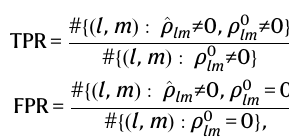
Fig. 2 | Comparisons of estimation accuracy and false/true positive rate (FPR/ TPR) for identifying linear relationships within an ecosystem. The average relative norm loss (Frobenius/Spectral) and FPR/TPR of various correlation meth- ods are shown in a , b , respectively. Synthetic data were generated from negative- binomial(NB)distributions.TheX-axisdenotesthesimulationsettings,whicharea combination of sample size n , number of taxa d , and the dispersion parameter α . Resultsarerepresentedbytheaverageofthecorrespondingmeasures(Frobenius/